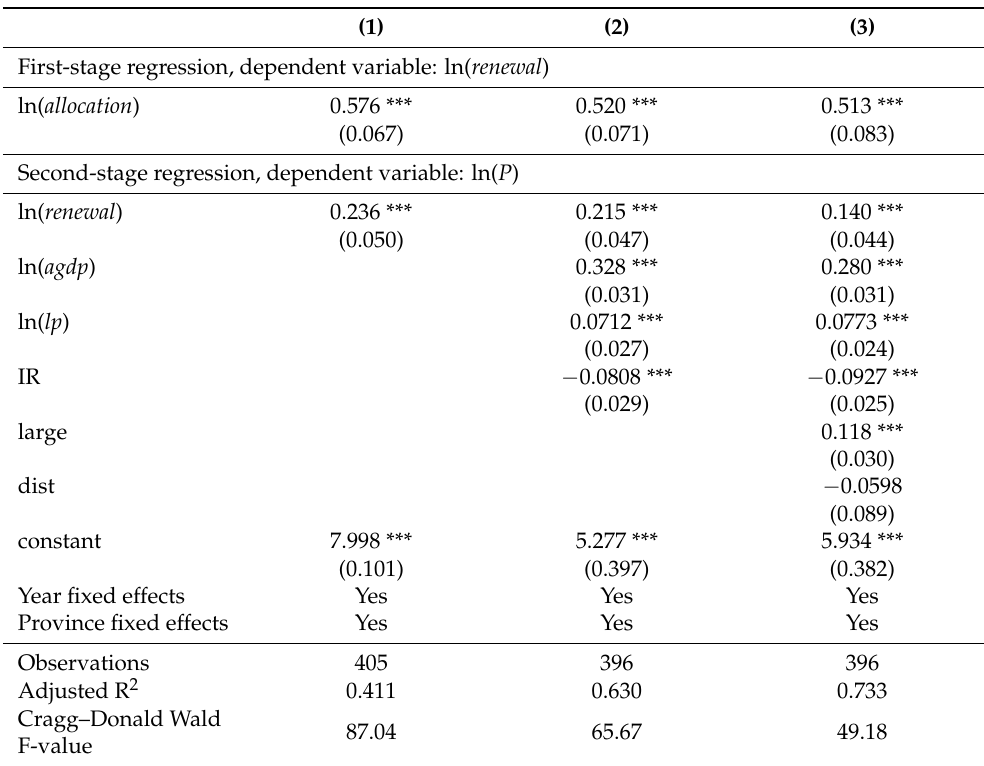
Table 4. The 2SLS estimation results.